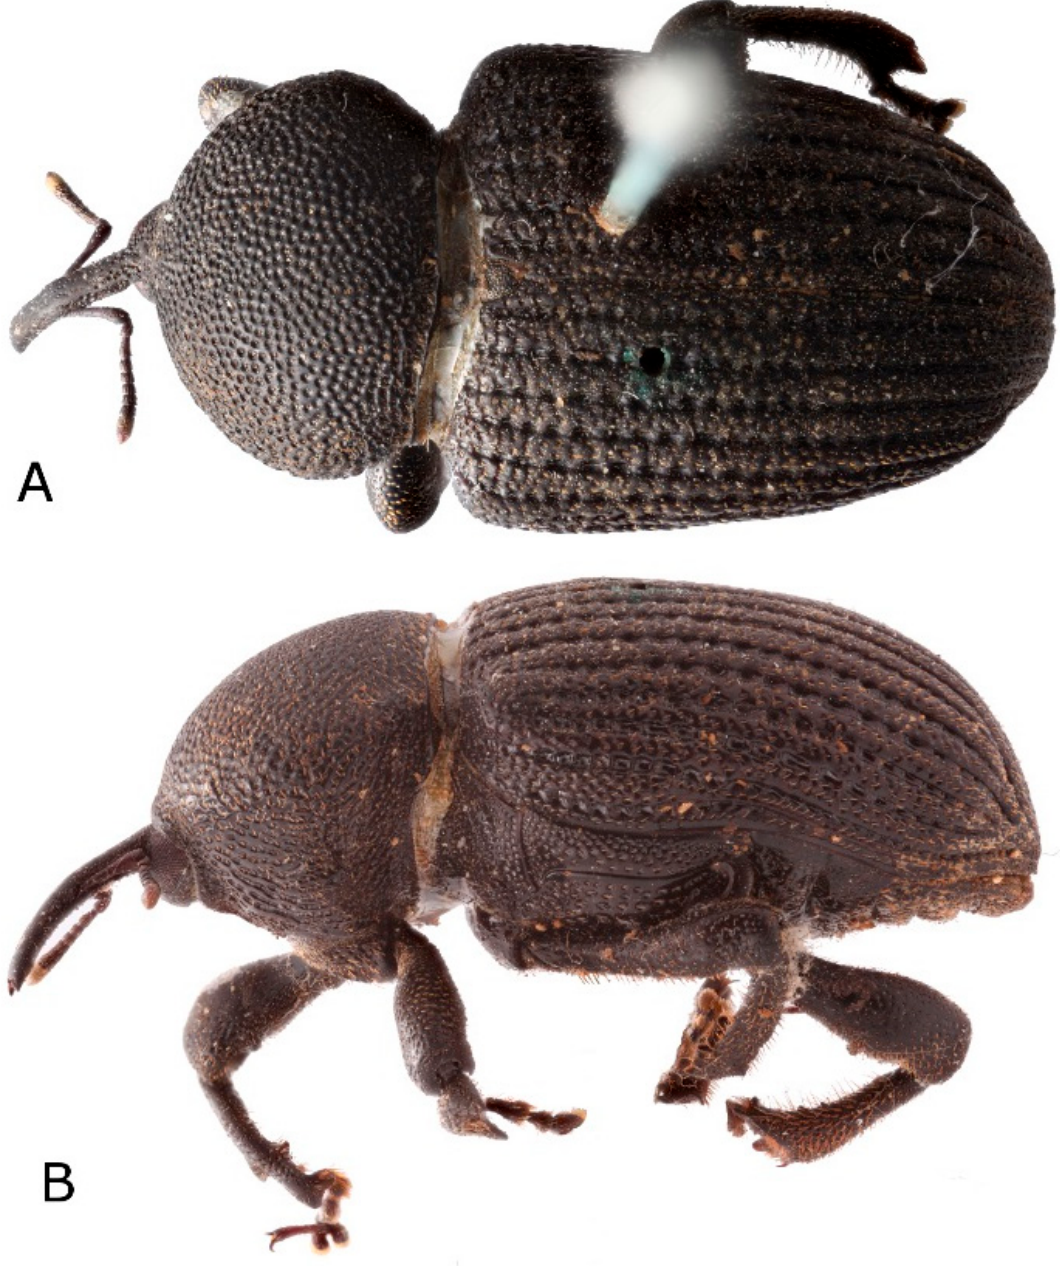
Figure 1. Sclerocardius africanus (Boheman) lectotype: ( A ) habitus, dorsal, ( B ) habitus, lateral. Photographed by Gunvi Lindberg (© 2018 Naturhistoriska riksmuseet). Original photo cropped, light levels and contrast adjusted. Made available by the Swedish Museum of Natural History under Creative Commons Attribution 4.0 International Public License, CC-BY 4.0.